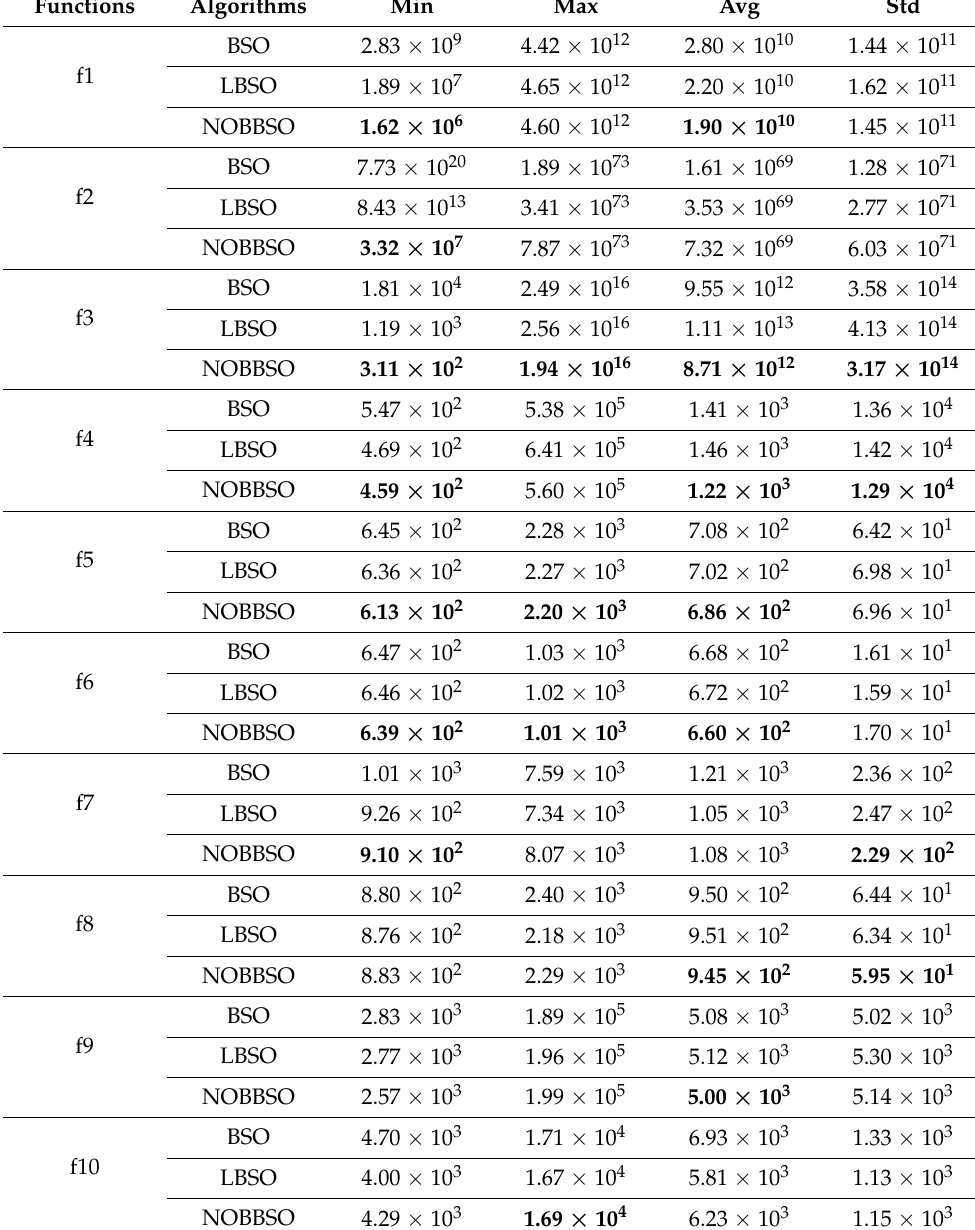
Table 4. Accurate results of three algorithms when D is 30.